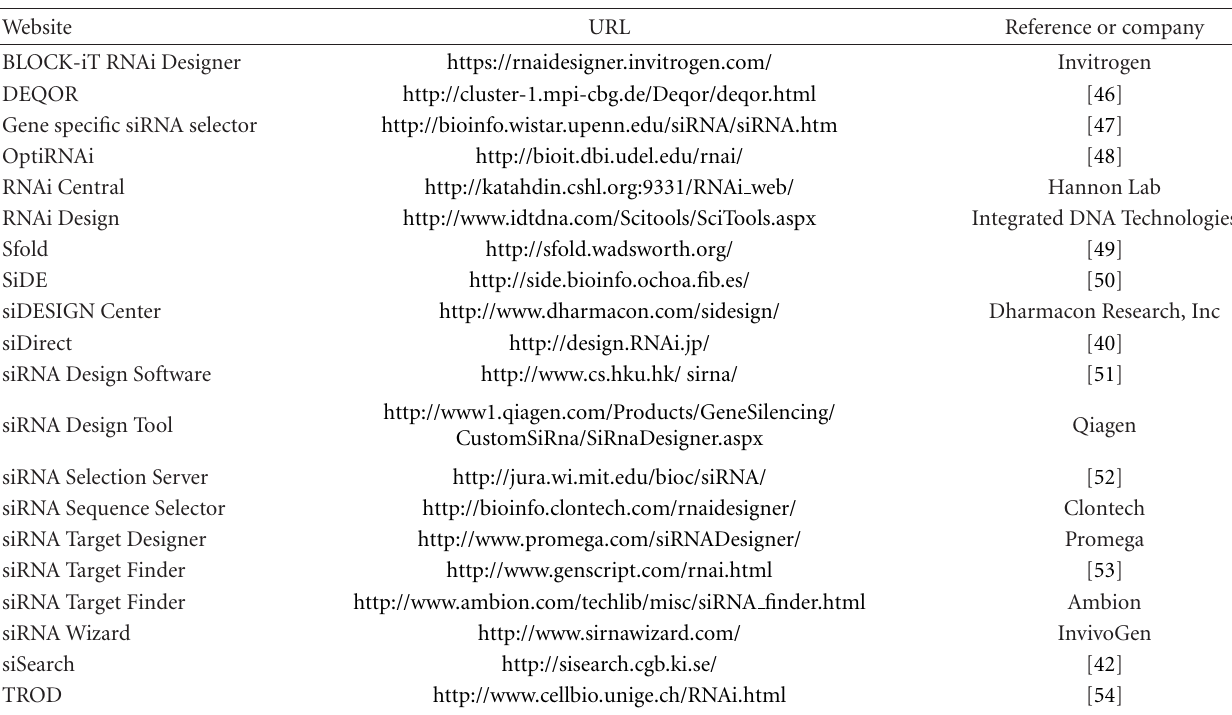
Table 1: siRNA search websites.